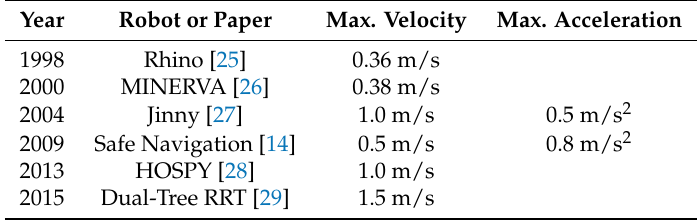
Table 1. Maximum translational velocities and accelerations of previous service